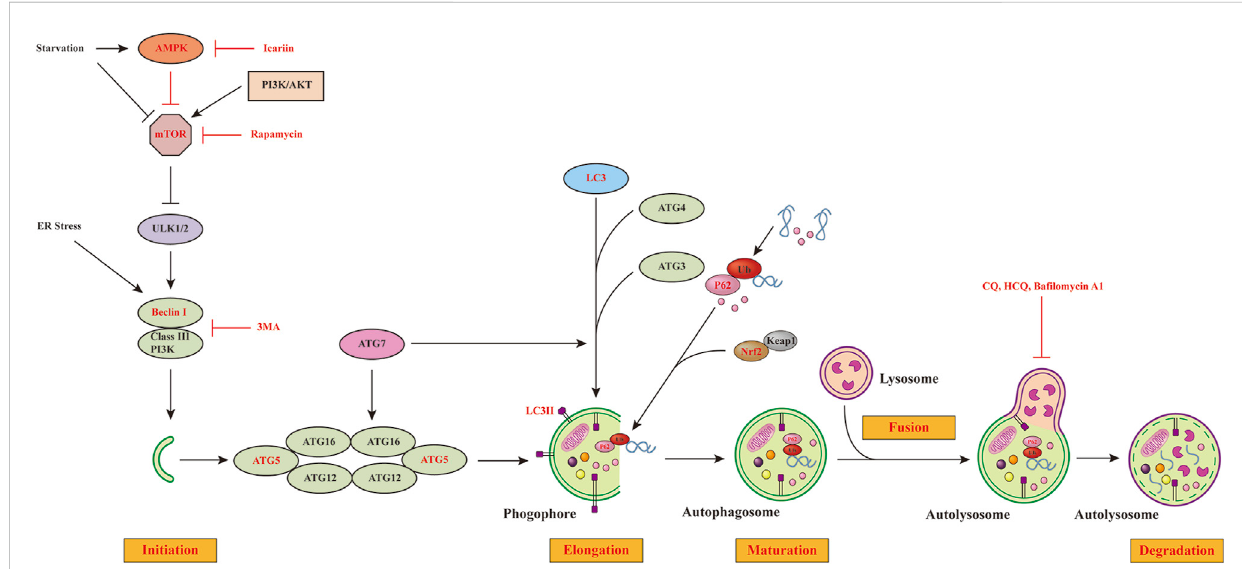
FIGURE 1 Majorregulatorysignalingpathwaysofautophagy.Autophagyisaprocessconsistingofinitiation,elongation,maturationanddegradationsteps.The PI3K-AKT pathway is the upstream activator of mTORC1, whereas AMPK initiates autophagy by inhibiting the mTORC1 activity or directly activating the ULK1/2 complex. mTORC1 activation inhibits autophagy by inhibiting the ULK1/2 complex, which is necessary for the induction of autophagy. When activatingtheULK1/2complex,itcanrecruitBeclin1/IIIclassPI3Kcomplexestothesiteofautophagosomeformation.LC3-IIexertsanessentialrole in the formation of autophagosome through binding to the autophagosomal membrane. P62 can serve as a connection between LC3 and ubiquitinated proteins.Autophagosomefuseswithlysosometoformautolysosome.Eventually,autolysosomeisdegradedbylysosomalenzymes.Wehavehighlighted in red the autophagic steps linked to in fl ammation, adipogenesis and HA accumulation in GO that have been discussed in this review. mTORC1, Rapamycin complex 1; ER, endoplasmic reticulum; rapamycin (mTOR) kinase; AMPK, AMP-dependent protein kinase; PI3K-AKT pathway, phosphoinositide3-kinase(PI3K) – proteinkinaseB(AKT)pathway;ULK1/2complex,UNC-51 – likekinase1or2;LC3,lightchain3protein;ATG,autophagy related genes; CQ, Chloroquine; HCQ,